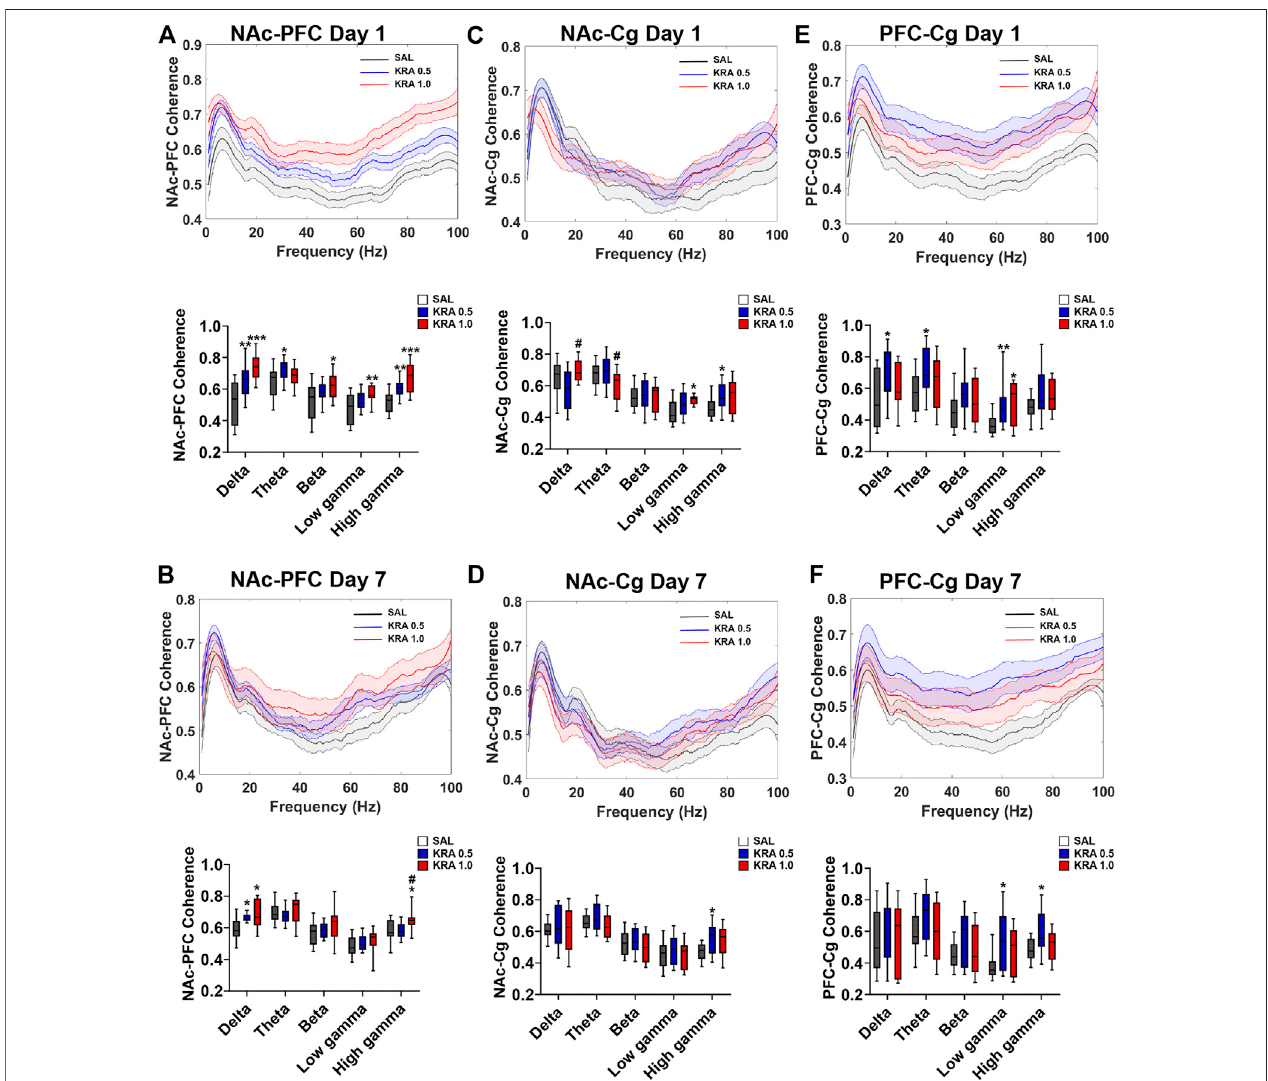
FIGURE6| Dose-dependenteffectsofacute and repeated kratom administration on NAc-PFC, NAc-Cg, and PFC-Cg coherence. Coherence acrossfrequencies and quanti fi cation showing the effect of acute and repeated low (0.5 mg/kg) or high (1 mg/kg) dose kratom 30 min post-injection. Data shown were taken from 30 s epochs. (A) Onday 1,both dosesofkratom increasedNAc-PFC delta and highgammacoherence.Lowdose kratom increased thetacoherenceand highdose kratom increased beta and low gamma coherence. (B) On day 7, both doses of kratom increased delta coherence whereas only high dose kratom induced an increase in high gamma coherence. (C) On day 1, high dose kratom increased low gamma NAc-Cg coherence whereas low dose kratom increased high gamma coherence. (D) NAc-Cg coherence wasincreased inthehigh gamma frequency bandonly inresponsetolowdose kratom onday 7. (E) Low dosekratom increasedlowfrequencyand low gamma coherence between the PFC-Cg. High dose kratom also increased coherence in the low gamma frequency band on day 1. (F) On day 7, only low dose kratom elevated PFC-Cg low and high gamma coherence. N (cid:2) 7 – 10 rats per group, with 2 electrodes/rat. Curves are represented as means with jackknife estimates of semdepictedbytheshaded areas.Quanti fi cationofcoherencearerepresentedasboxplotswithmin/maxvalues.* p < 0.05,** p < 0.01,*** p < 0.001comparedtosaline control rats. # p < 0.05 compared to low dose kratom treated rats.